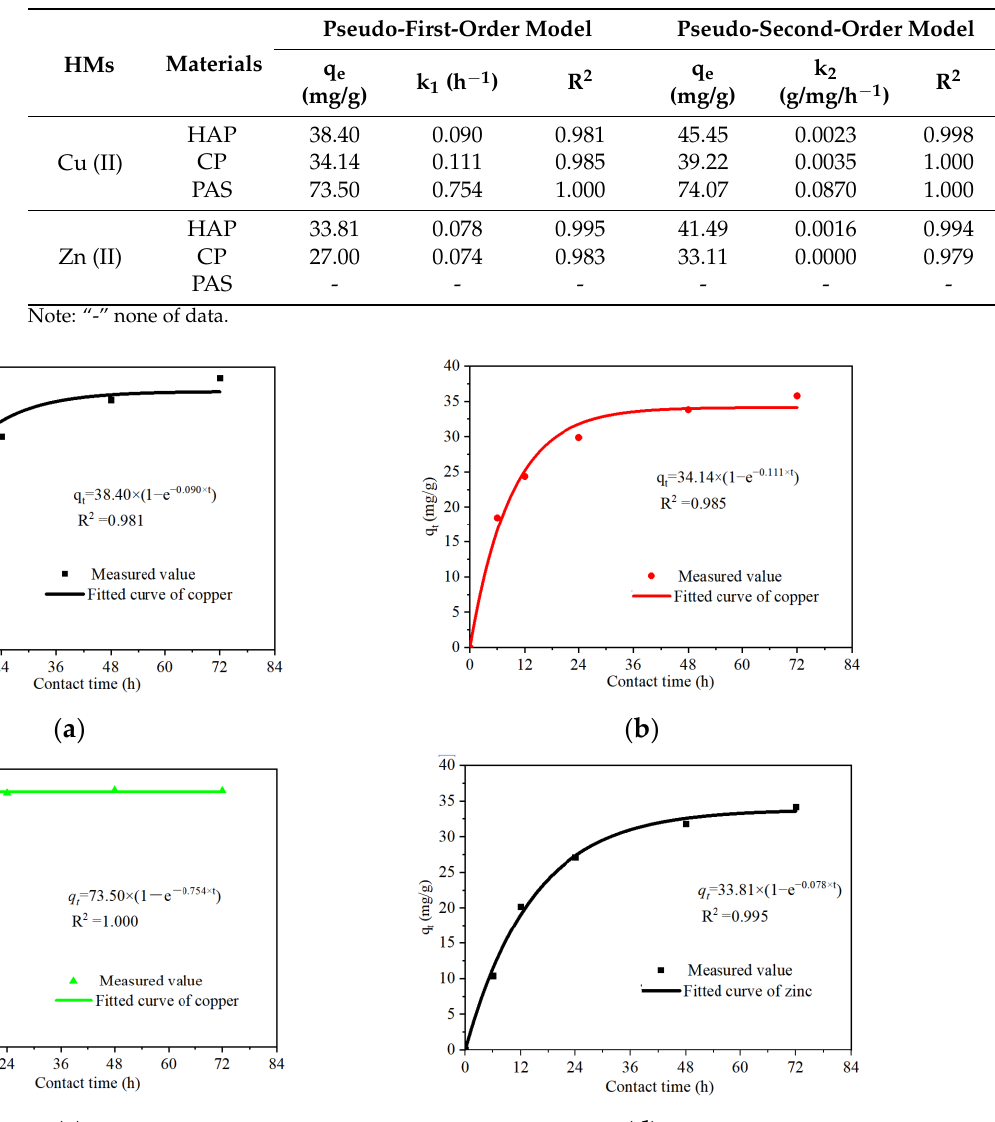
Table 2. Kinetic parameters of pseudo-first-order and pseudo-second-order models for adsorption of copper and zinc by phosphates.